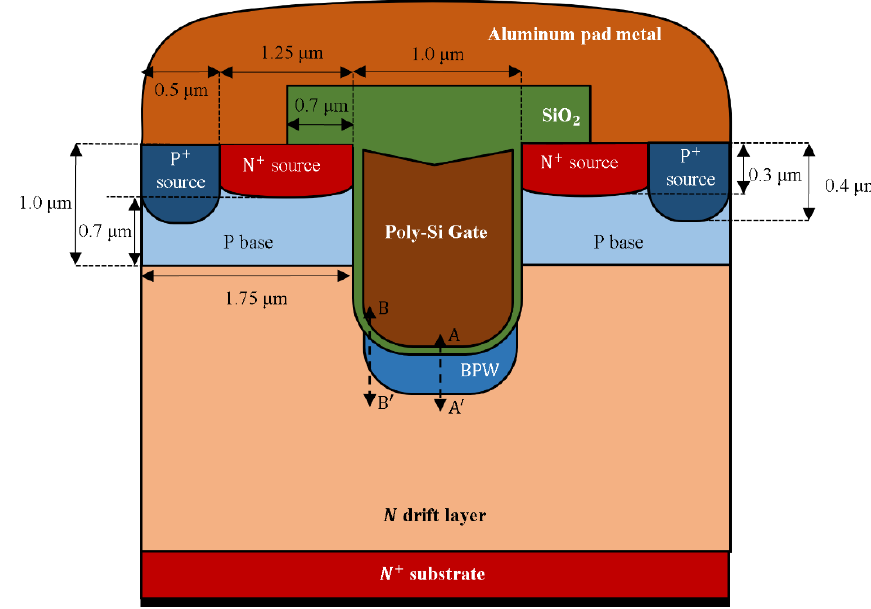
Figure 1. Cross-sectional view of the 1.2-kV 4H-SiC Trench-gate MOSFET.